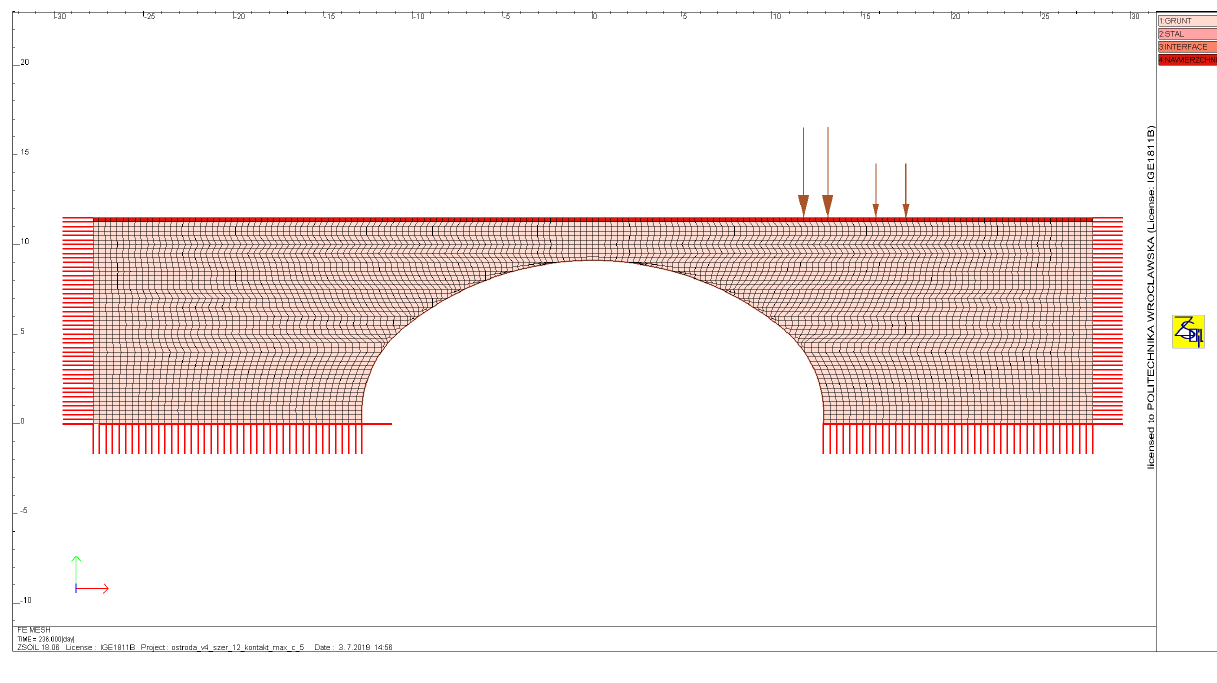
Figure 10: Vehicular loading as a system of nodal forces.